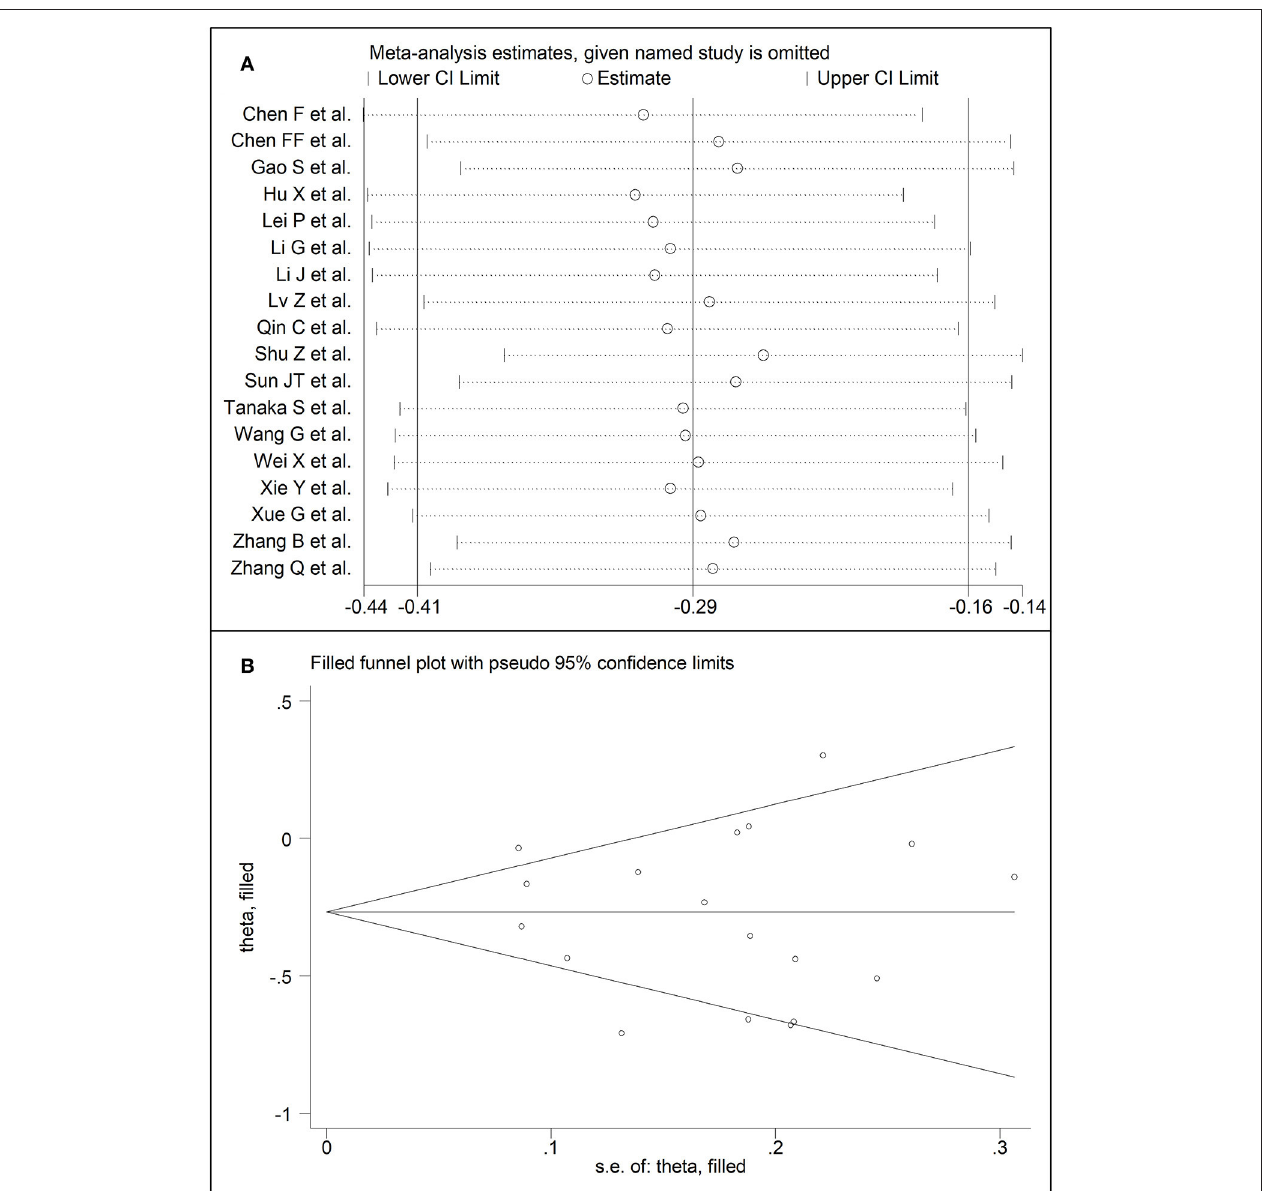
FIGURE 3 | (A) Sensitivity analysis of the association between total cholesterol and COVID-19. The influence of individual studies on the overall standardized mean difference (SMD) is shown. The middle vertical axis indicates the overall SMD and the two vertical axes indicate the 95% confidence intervals (CIs). The hollow circles represent the pooled SMD when the remaining study is omitted from the meta-analysis. The two ends of each broken line represent the 95% CIs. (B) Funnel plot of studies investigating low vs. high severity or surviving vs. non-surviving status after trimming and filling. Dummy studies and genuine studies are represented by enclosed circles and free circles,